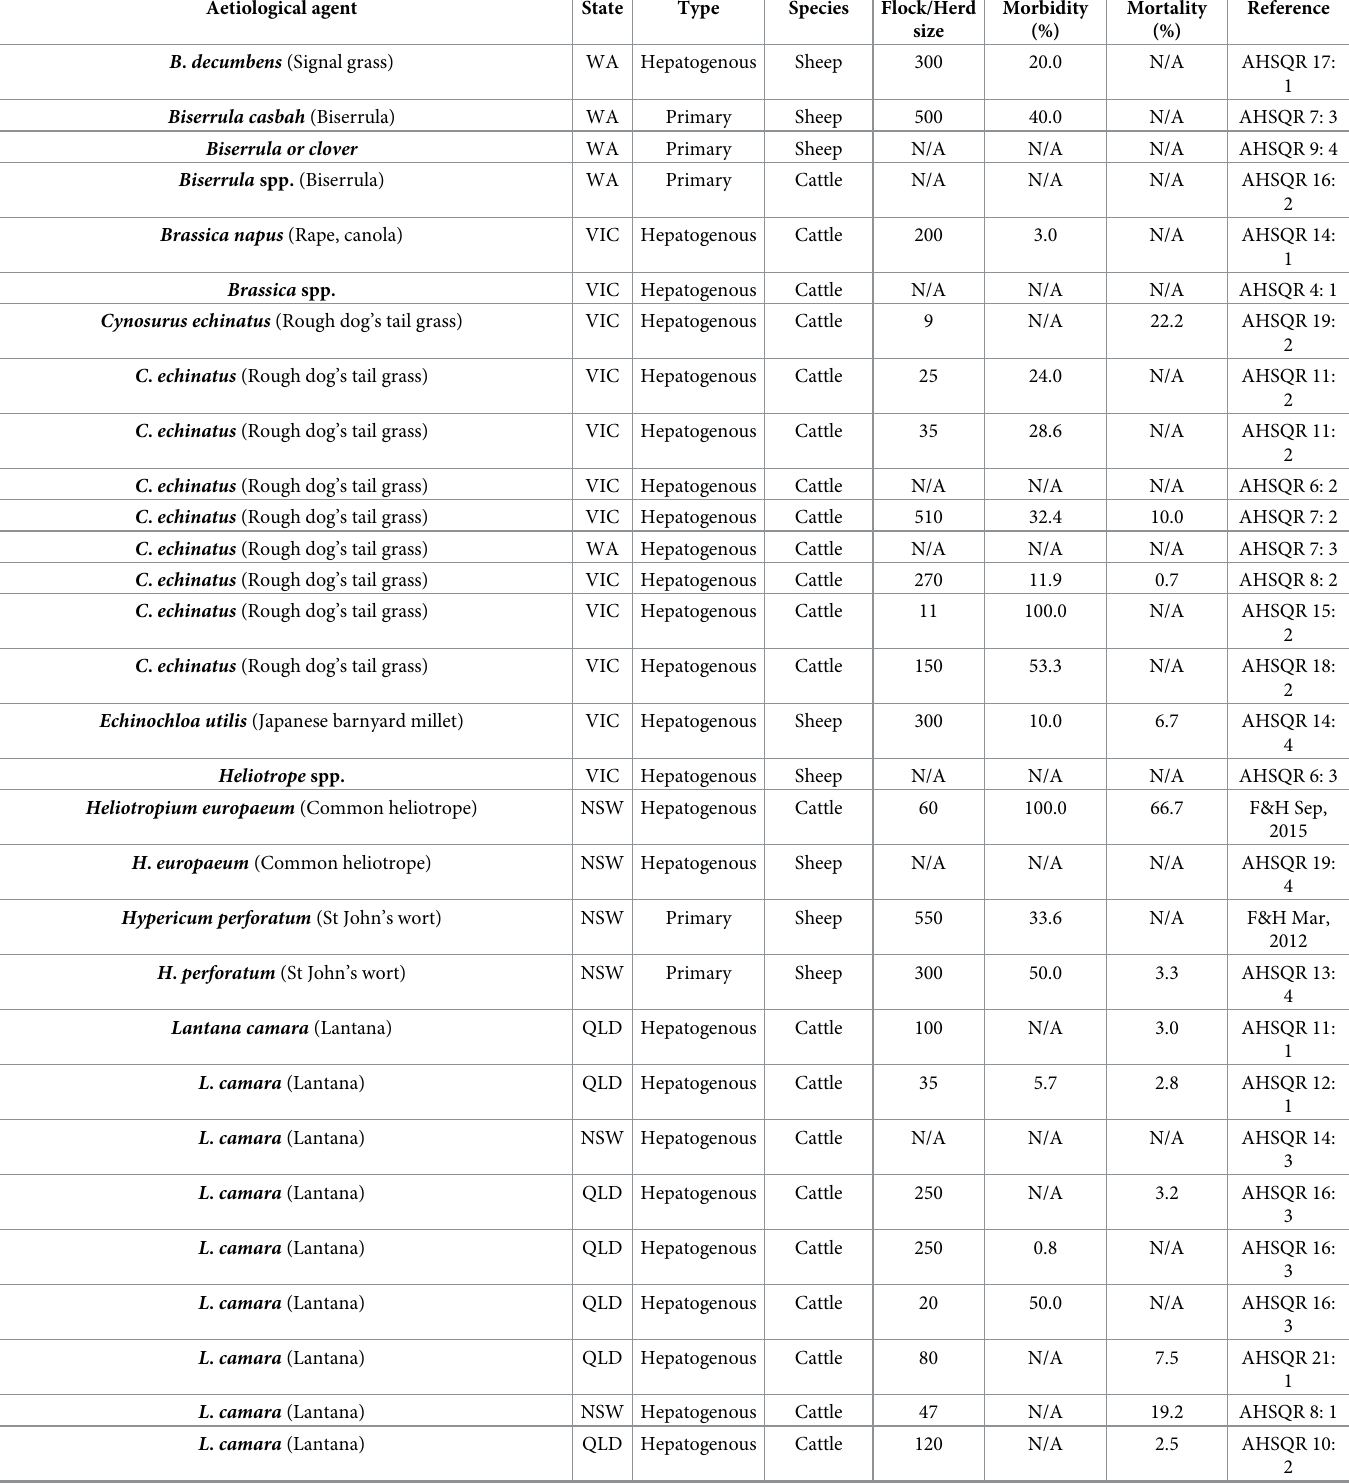
Table 2. Photosensitisation outbreaks in livestock in Australia extracted from two non peer-reviewed publication series. Percentage morbidity and mortality are included where